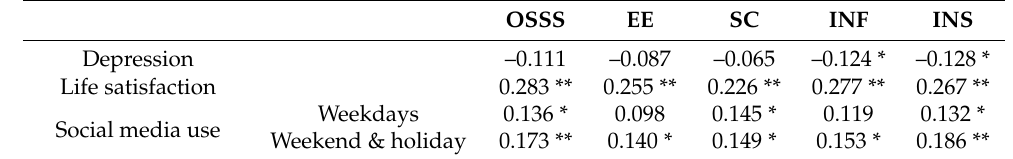
Table 6. Results of criterion validity among the cross-validation